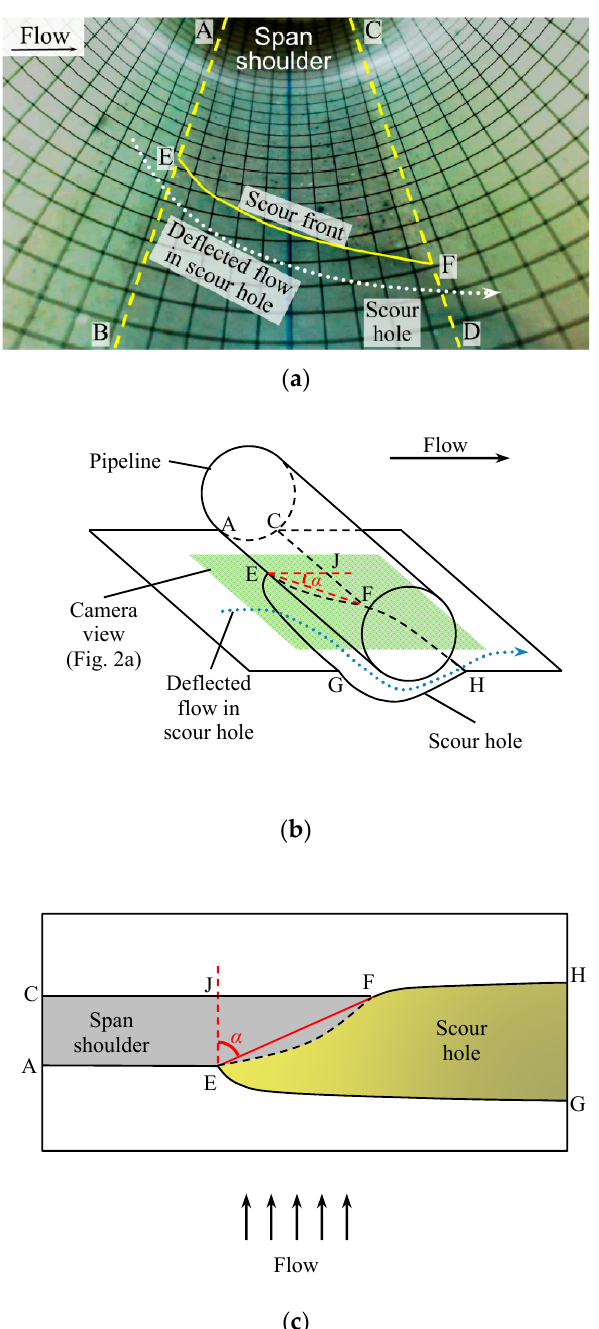
Figure3. Photoandsketchofthescourfront: ( a )Typicalviewofminiaturecamera; ( b )three-dimensional Figure 3. Photo and sketch of the scour front: ( a ) Typical view of miniature camera; ( b ) sketch; ( c ) top view of the sediment bed (pipeline three-dimensional sketch; ( c ) top view of the sediment bed (pipeline removed).